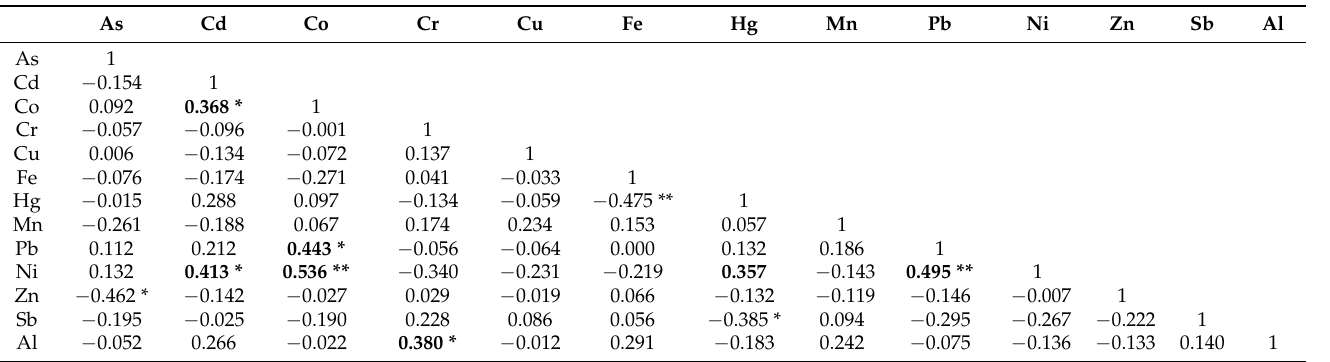
Table 4. Correlation matrices of the investigated HMs. As